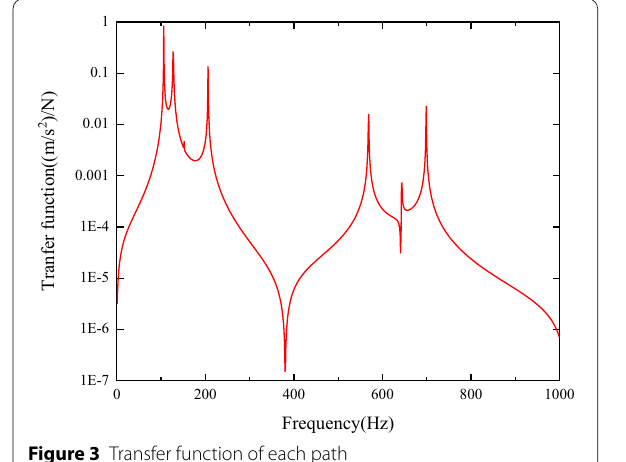
Figure 3 Transfer function of each path